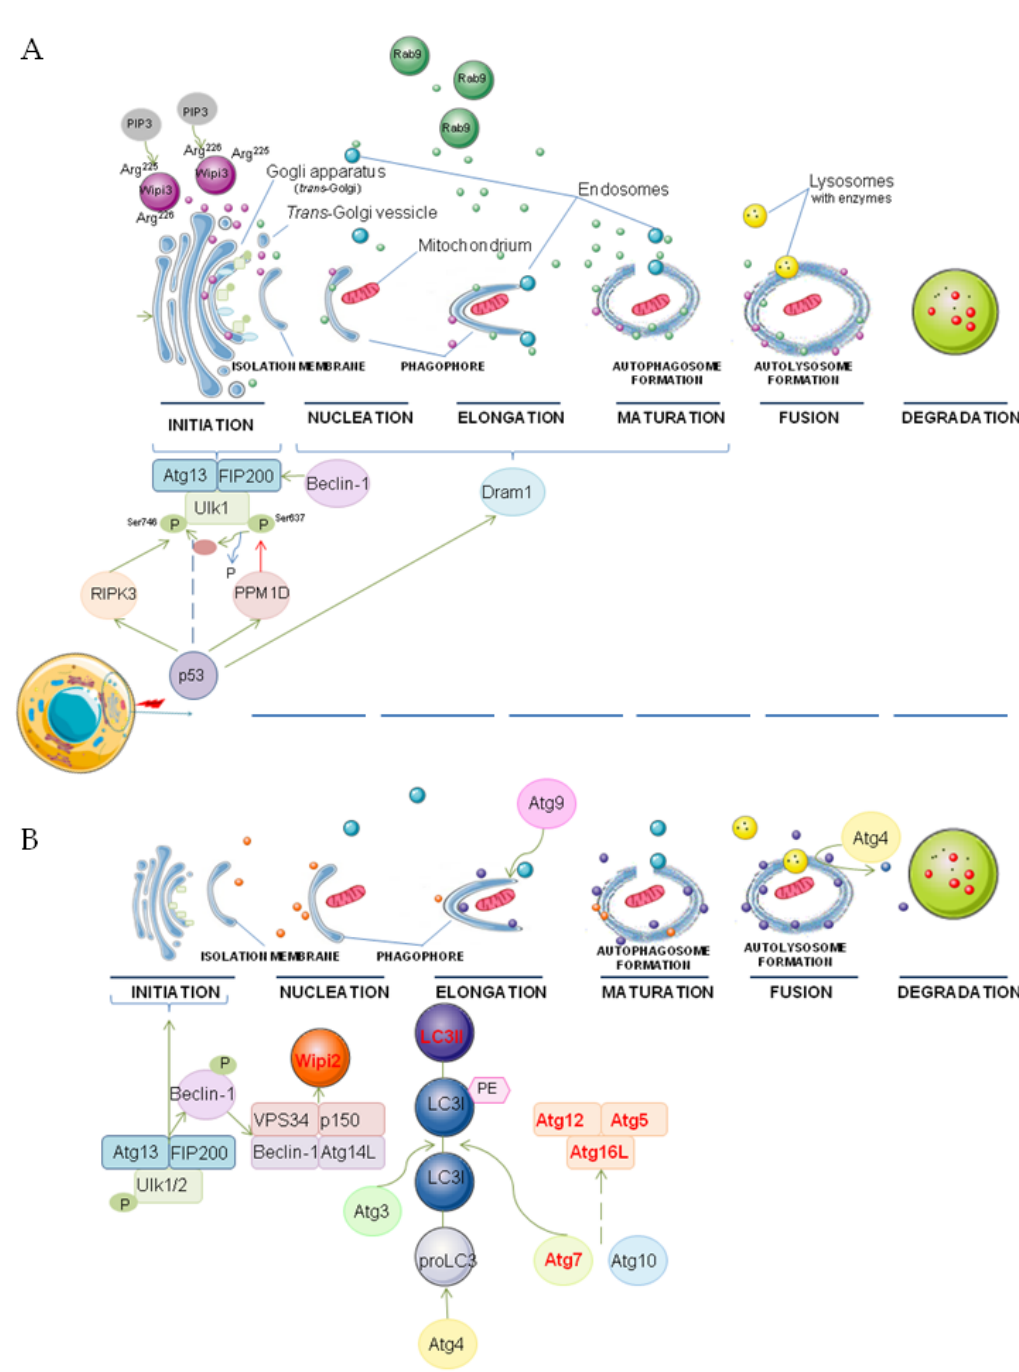
Figure 1. The possible molecular mechanism of genotoxic-induced alternative ( A ) and canonical ( B ) autophagy indicating proteins and organelles involved in these processes. P — phosphorylation, PE — phosphatidylethanolamine. The main figure conception was partially adapted from [47,52]. Graphical elements were adapted from Servier Medical Art (smart.servier.com accessed on 11 November 2021).